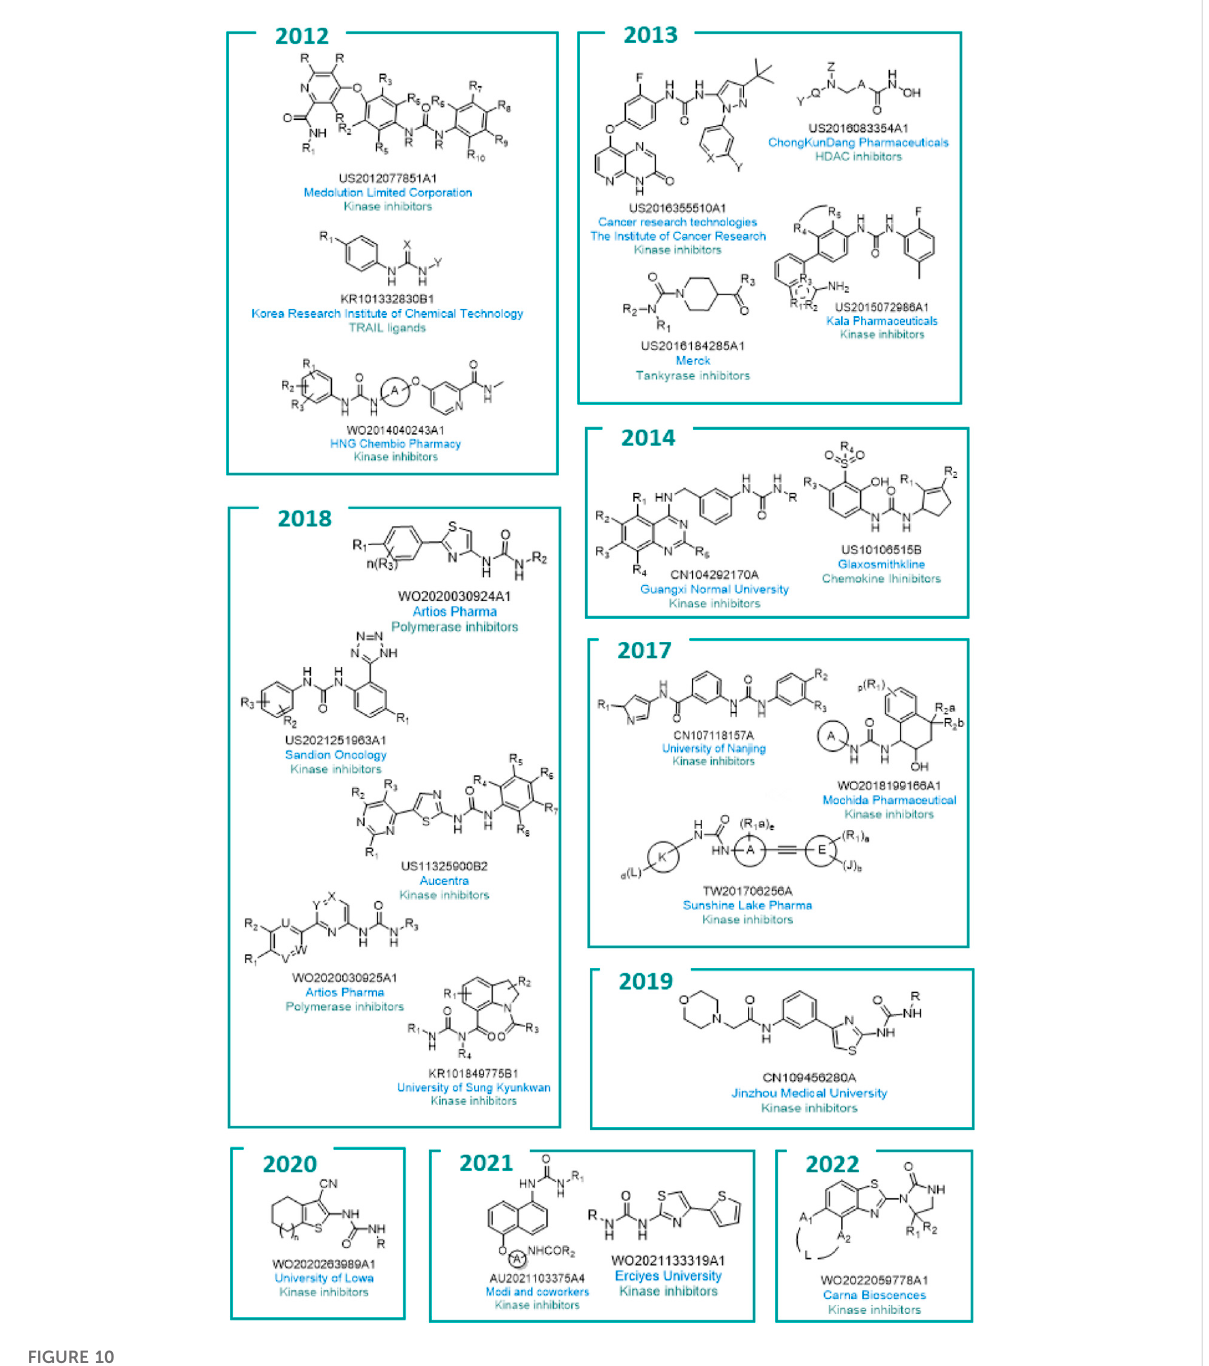
FIGURE 10 General structures of the different patented